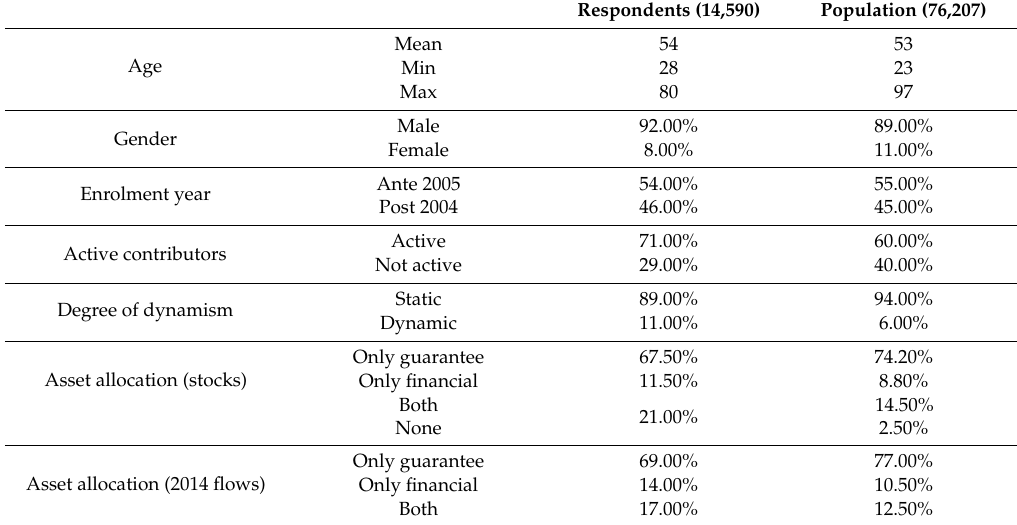
Table A2. Socio-demographic, behavioral, and financial features of respondents vs. entire